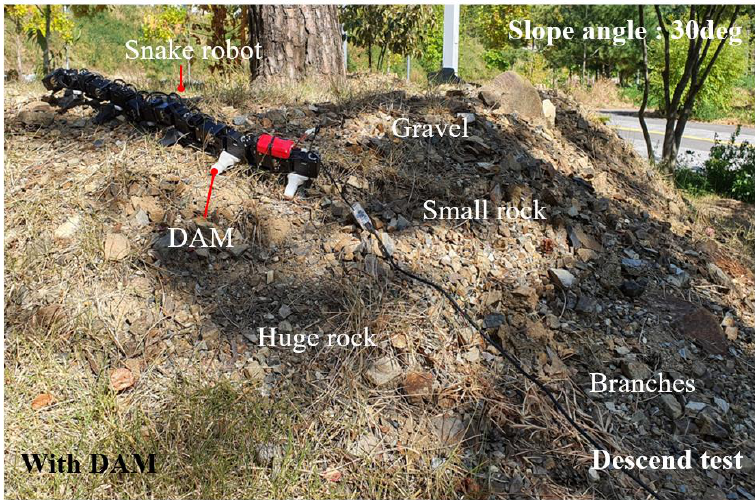
Figure 13. Descending environment composed of obstacles.